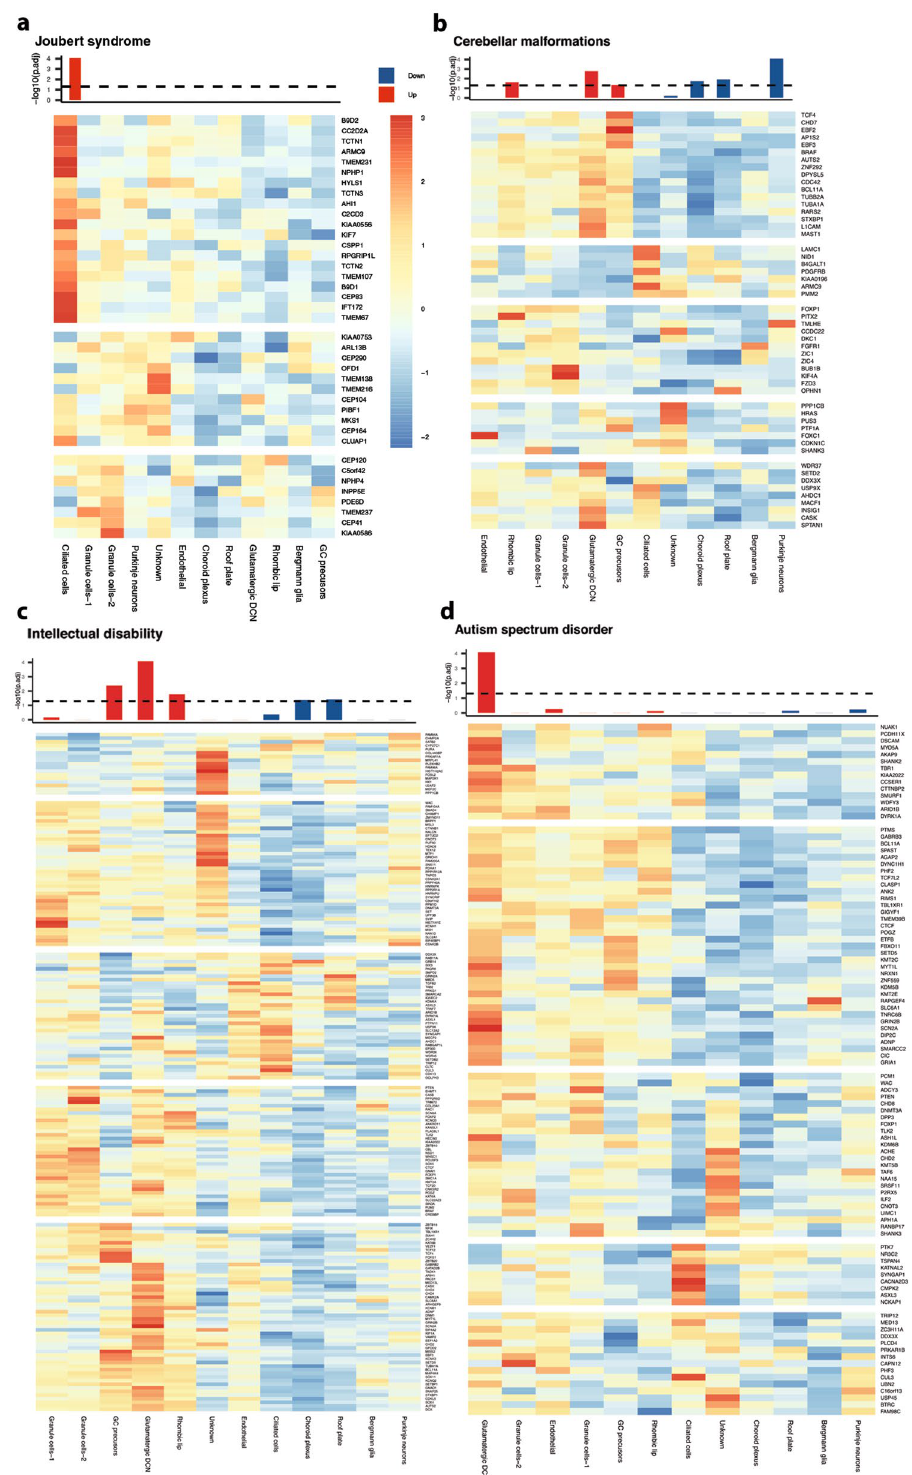
Figure 5. Enrichment of disease genes in discrete organoids cell populations. Heatmaps showing the average scaled expression across each of human organoid-derived cell type of risk genes for ( a ) Joubert Syndrome, ( b ) cerebellar malformation, ( c ) intellectual disability and ( d ) autism spectrum disorder. Enrichment p-values (-Log10 P value) for each cell type based on GSEA (each cell type vs all others) are shown in the top bar plots. The dashed line is the Bonferroni significance threshold (P < 0.05). Bonferroni correction was calculated by dividing nominal p-value by total number of cell types and gene sets (12 × 6). The colour of each bar in the barplot shows upregulation (red) or downregulation of gene set in particular cell type vs all other cell types based on positive or negative NES values from GSEA results (Supplementary Table S37). Heatmaps were generated using Pheatmap